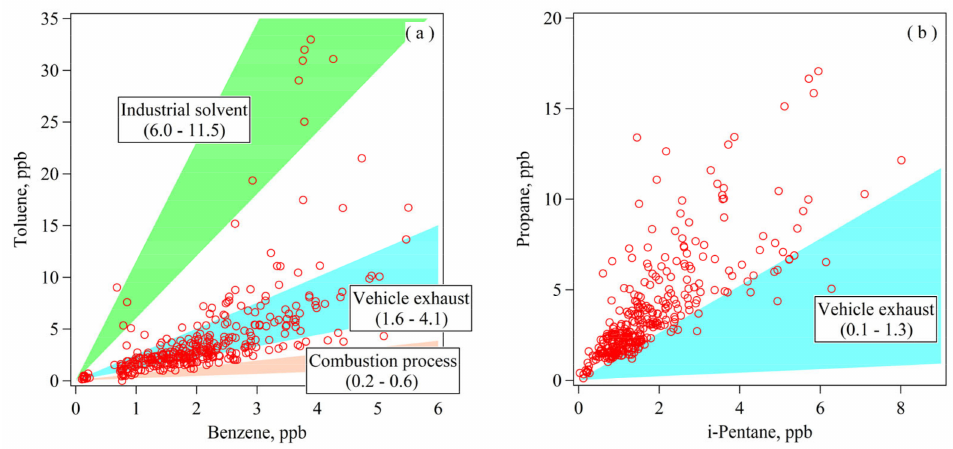
Figure 6. Scatter plots for ( a ) toluene versus benzene and ( b ) propane versus i -pentane based on online measurements at the S1 site.